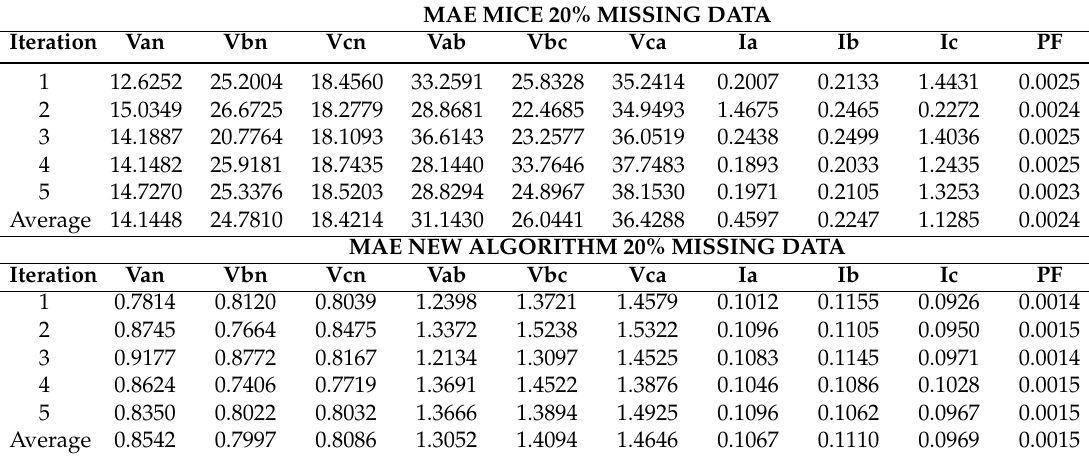
Table 9. MAE obtained with a 20% of missing data MICE and new proposed AAA package.